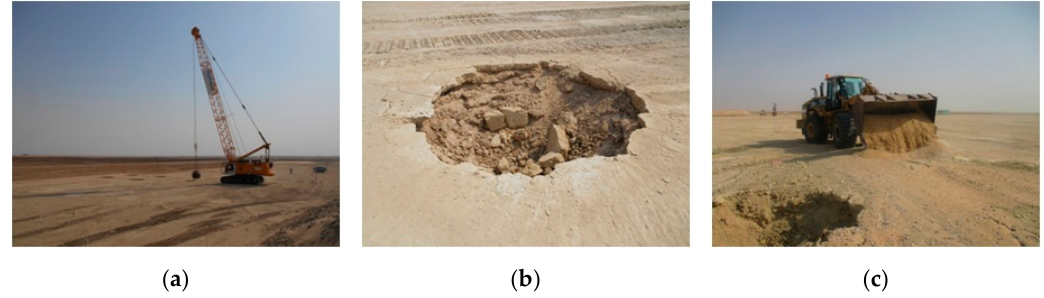
Figure 14. Trial dynamic compaction: ( a ) crane; ( b ) crater; ( c ) filling crater with gatch.